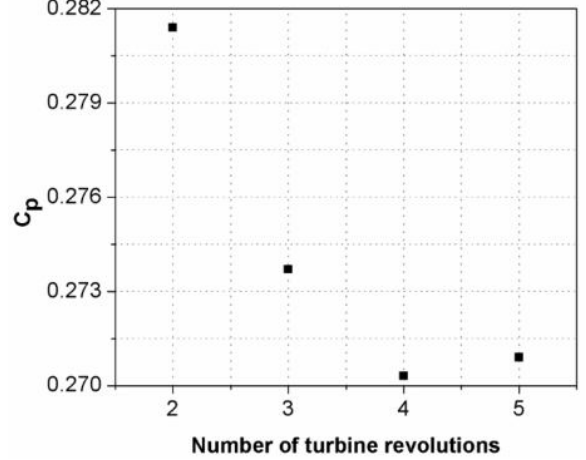
Figure 3. Relative change of C p with respect to turbine revolutions